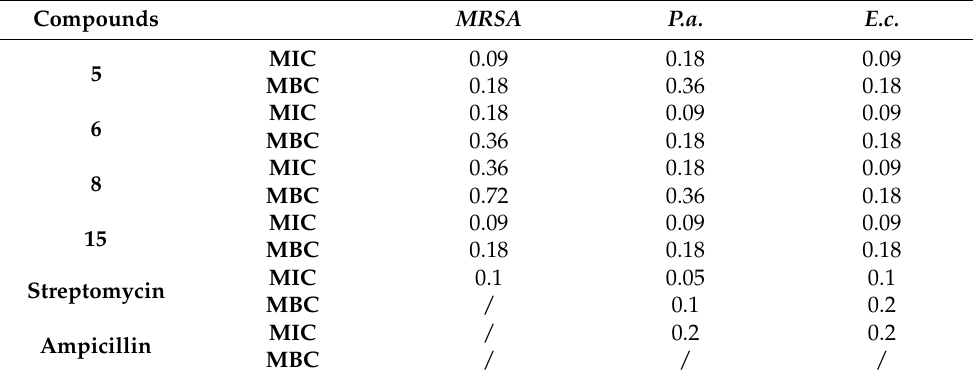
Table 2. Antibacterial activity of selected compounds toward resistant bacterial strains; results are in mg/mL; MIC—minimal inhibitory concentrations; MBC—minimal bactericidal